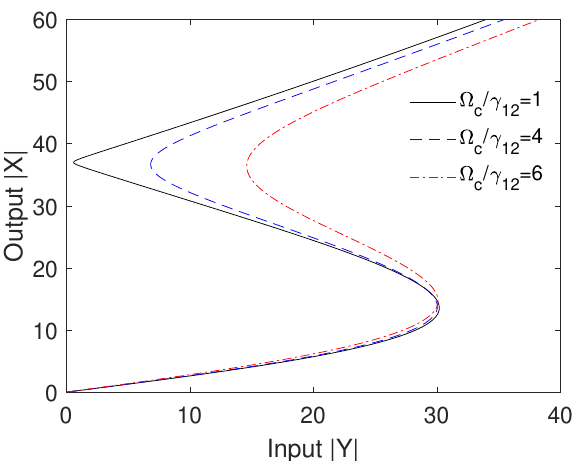
Figure 2. Output versus input for different values of the Rabi frequency of the control field. The other ∆ p = 0, ∆ c = 6, R = 20nm, R = 5nm, θ parameters are M γ 12 γ 12 mobility of GND is µ = 10 4 cm 2 V − 1 s − 1